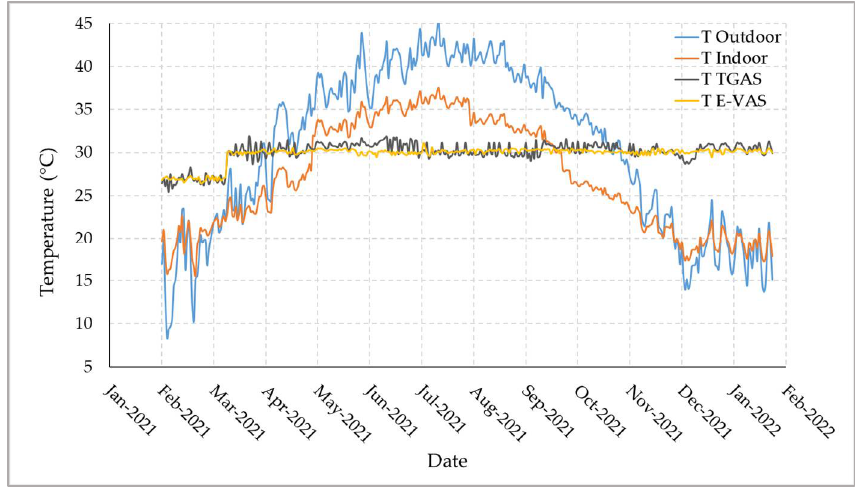
Figure 9. Average temperatures of the outdoor (T Outdoor), the indoor (T Indoor), the traditional greenhouse acclimatization system (TGAS), and the designed ex vitro acclimatization system (E- VAS).